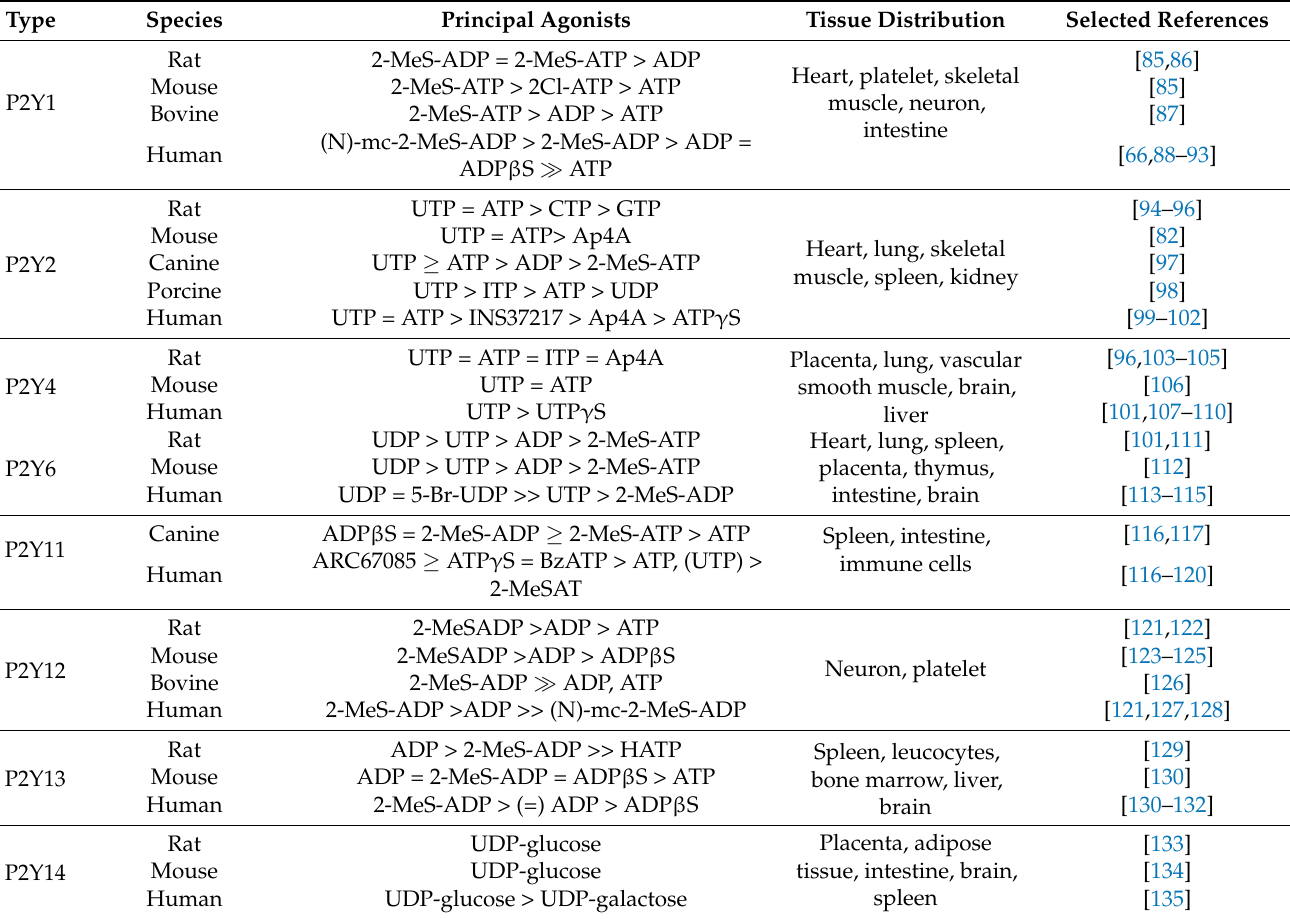
Table 1. P2Y-receptor subtypes expressed in mammalian tissues and their agonist